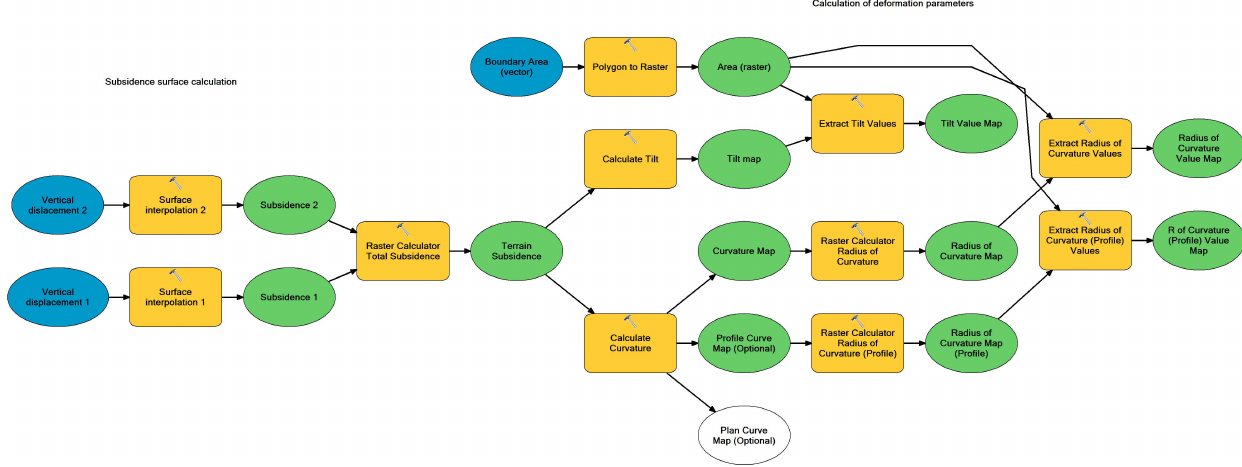
Figure 6. Diagram of the geoprocessing model for the calculation of the tilt and radius of curvature parameters of the subsidence surface.